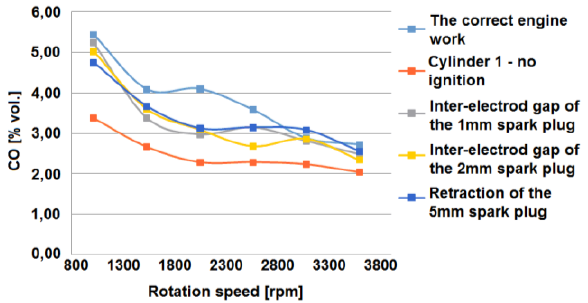
Fig. 13. The content of carbon monoxide in the exhaust gas of the BMW M10B18